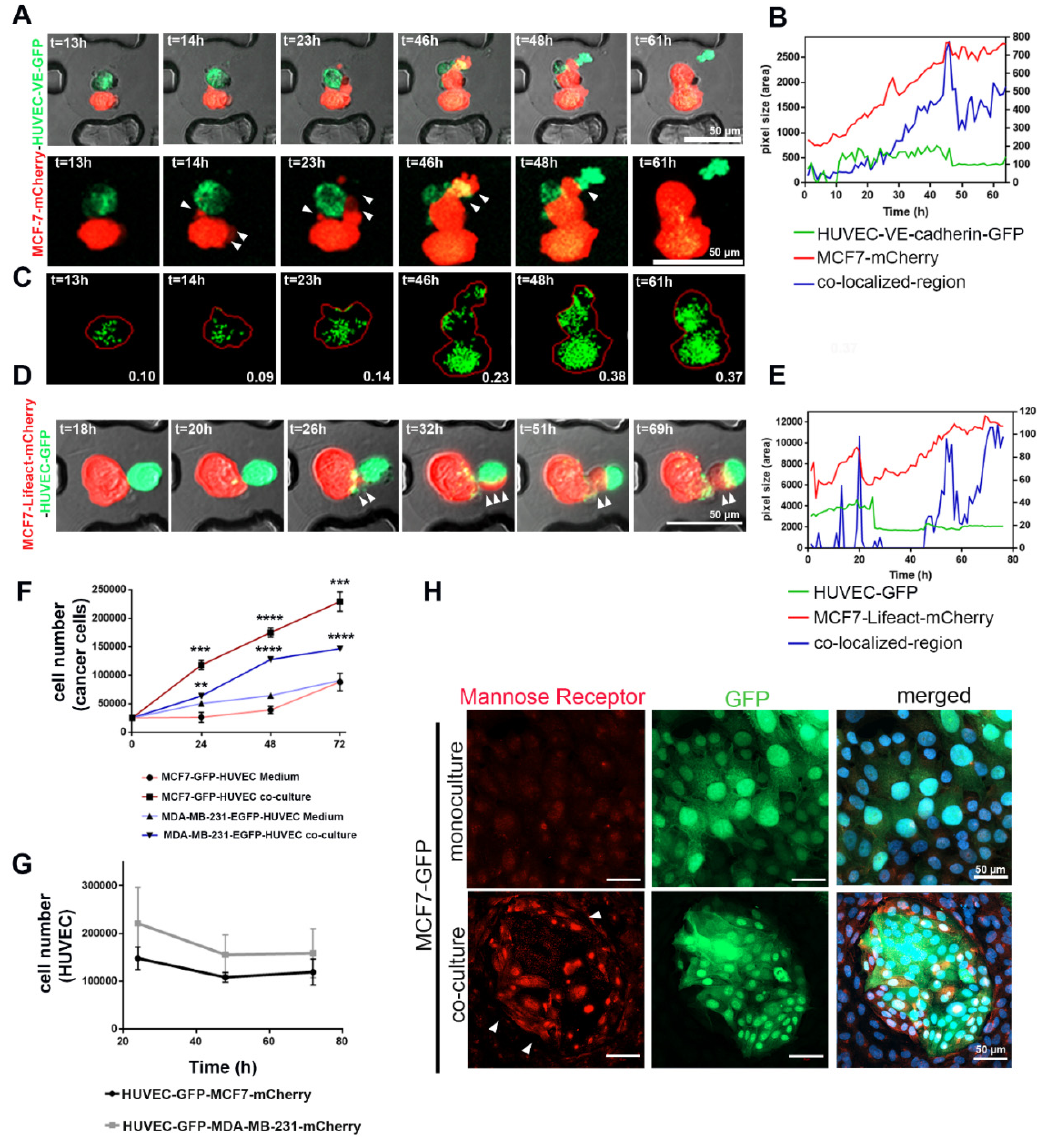
Figure 7. Phagocytosis contributed to the internalization of HUVEC-secreted EVs by cancer cells, as well as the opposite mutual e ff ects between the two cell types on proliferation. ( A ) The MCF7-mCherry and HUVEC-expressing VE-cadherin-GFP or ( D ) MCF7 expressing lifeact-mCherry and HUVEC-GFP were encapsulated inside agarose beads and monitored by live-cell imaging. Images were taken with confocal microscopy and 10 × magnification at 37 ◦ C. ( B , E ) The fluorescence area of mCherry (MCF7 cells), GFP, or VE-cadherin-GFP (HUVECs), as well as the area of colocalized fluorescence, were quantified from time-lapse microscopy images (( A , D ) respectively) by using the CellProfiler software. ( C ) The CellProfiler software visualized VE-cadherin-GFP vesicles transferred from HUVECs to MCF7-mCherry, enabling their quantification. ( F ) Time course of proliferation of MCF7 and MDA-MB-231 cell lines during co-culture with HUVECs or treated with HUVEC-conditioned medium for di ff erent time points (24, 48, and 72 h). Values are presented as means ± SD ( n = 3) (** p ≤ 0.01; *** p ≤ 0.001; **** p ≤ 0.0001). ( G ) The proliferation of HUVECs co-cultured with TCs for 24, 48, and 72 h was analyzed by using flow cytometry ( n = 4). ( H ) MCF7-GFP cells in culture without and with HUVECs for 72 h were immunofluorescently stained for mannose receptor (red). Its expression was involved in e ff erocytosis, especially in the TCs, which were close to HUVECs